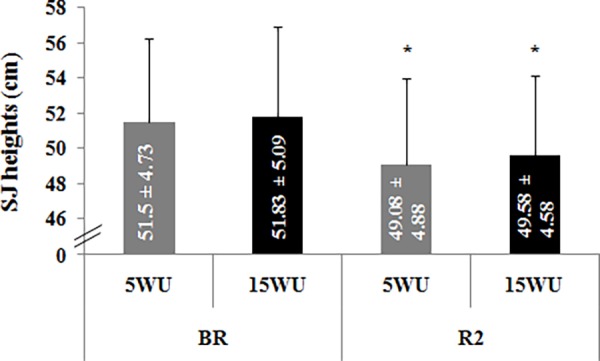
Squat jump heights (cm) (mean ± SD, n = 12) measured after the 5-minute (5WU) and the 15-minute (15WU) warm-up, before (BR) and during (R2) Ramadan.*: significant difference in comparison with BR.